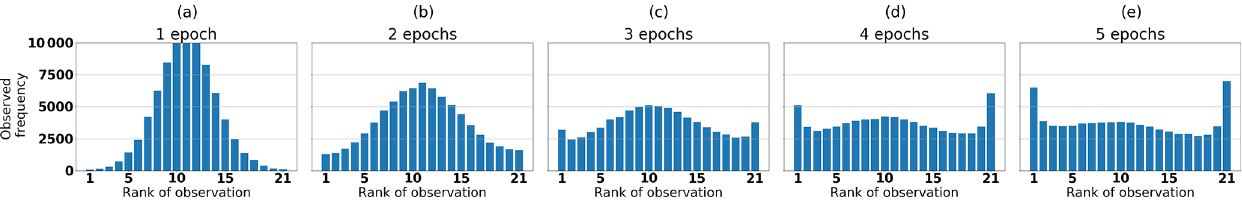
Figure 9. Rank histograms of the single MLP ensemble (SMLP) with 120 neurons in the hidden layer for different numbers of epochs, evaluated on the validation data